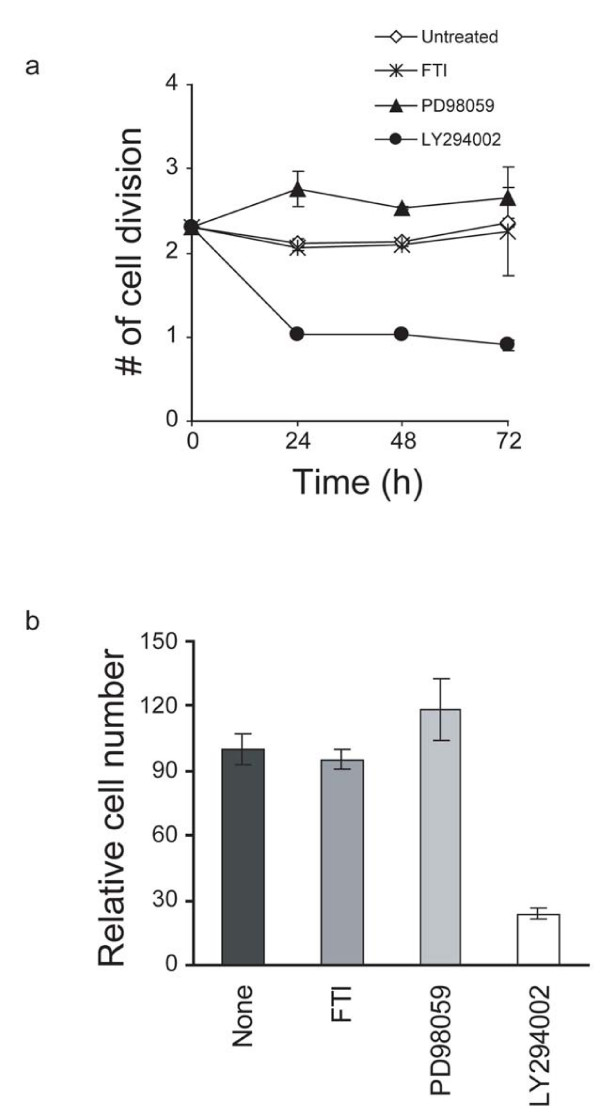
Effects of inhibiting PI3 K/PI3K/Akt or Raf/MEK/Erk on growth of RoSH2 cells. RoSH2 cells were pre-labeled with CFDA, cultured on gelatin-coated plates for 24 hours. One quarter of the plates were not treated with any inhibitor (N), one quarter with 10 μM Ras inhibitor, FTase inhibitor III (FTI), one quarter with 50 μM MEK inhibitor PD98059 (PD), and the last quarter with LY 294002 (LY). Each of the media with the appropriate inhibitors was replaced every twenty-four hours. At 0, 24, 48 and 72 hours after plating, cells were harvested and were assayed for cellular fluorescence by flow cytometry. The number of cell cycles for every 24 hours was calculated as described in Materials and Methods. b) Effects of FTI and PD98059 on cell numbers. Twenty-four hours after treatment with FTI, PD98059 or a combination of both drugs, the cell numbers were counted and normalized against that of untreated cells. Cell number at time 0 was designated as one.